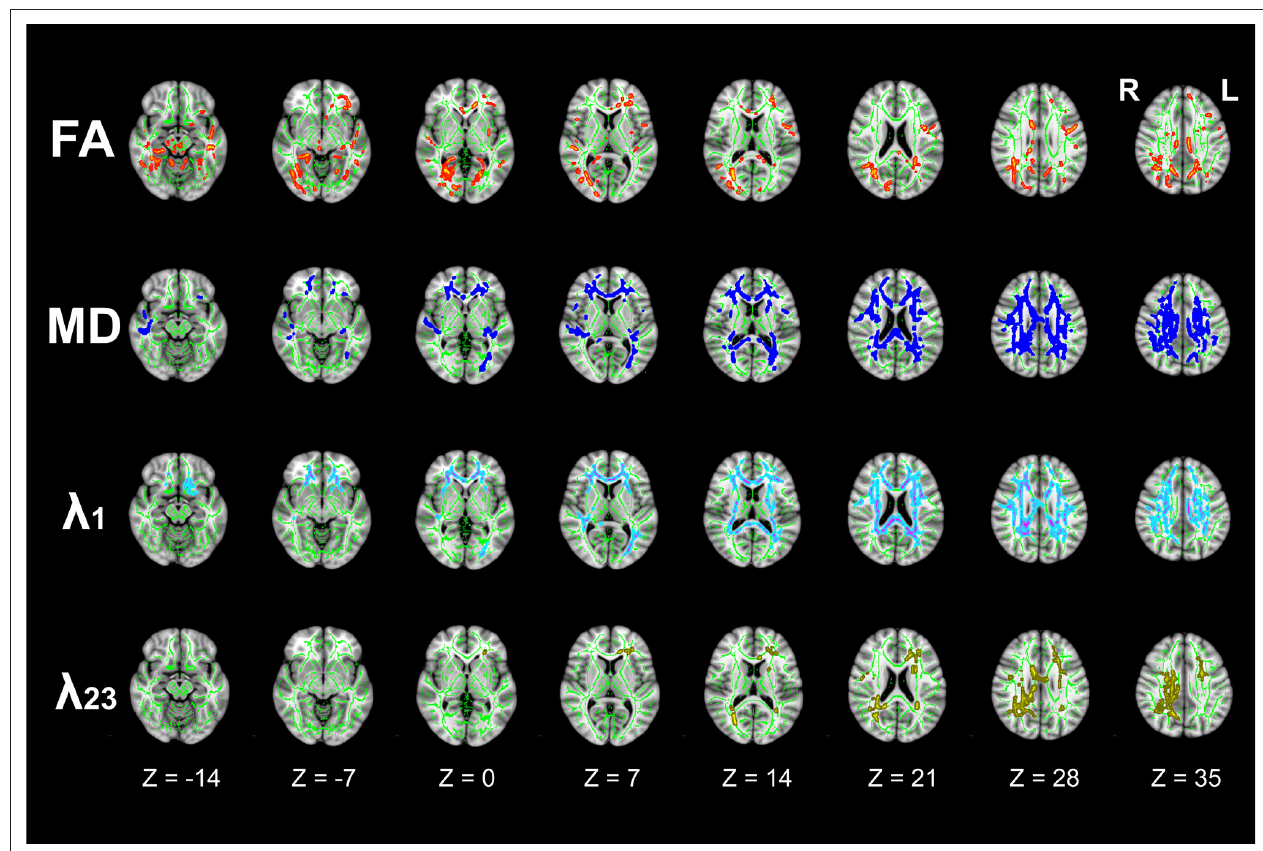
FIGURE 2 | Differences in tract-based spatial statistics (TBSS) analysis results of fractional anisotropy (FA), mean diffusivity (MD), λ 1 , and λ 23 images between T2DM and HC groups (axial images). Green regions represent the mean FA skeleton of all subjects. Red regions represent tracts with decreased FA, Deep-blue regions represent tracts with increased MD, Light-blue regions represent tracts with increased axial diffusivity ( λ 1 ), and Yellow regions represent tracts with increased radial diffusivity ( λ